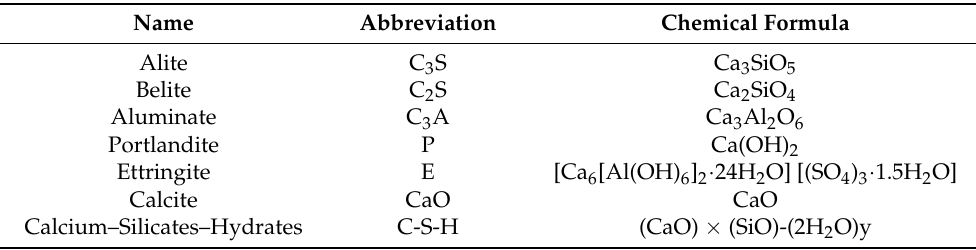
Table 2. Chemical phases present in the